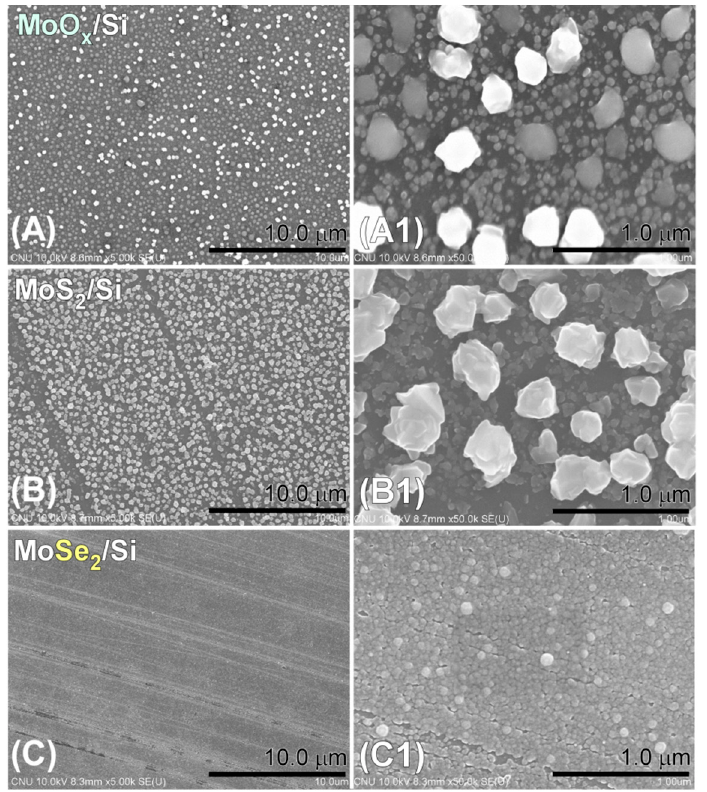
Figure 1. Scanning electron microscope (SEM) images of MoO x / Si ( A and A1 ), MoS 2 / Si ( B and B1 ) and MoSe 2 / Si ( C and C1 ) samples.